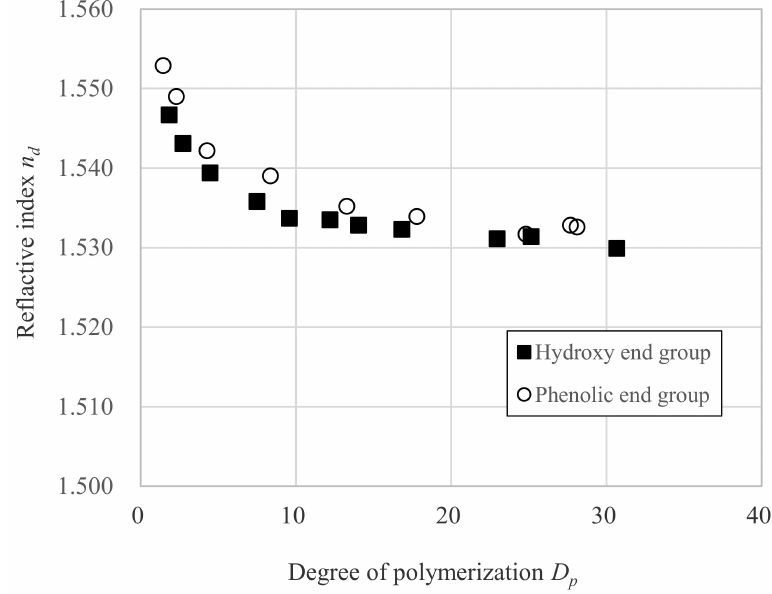
Figure 3. Relationship between degree of polymerization D p and refractive index n